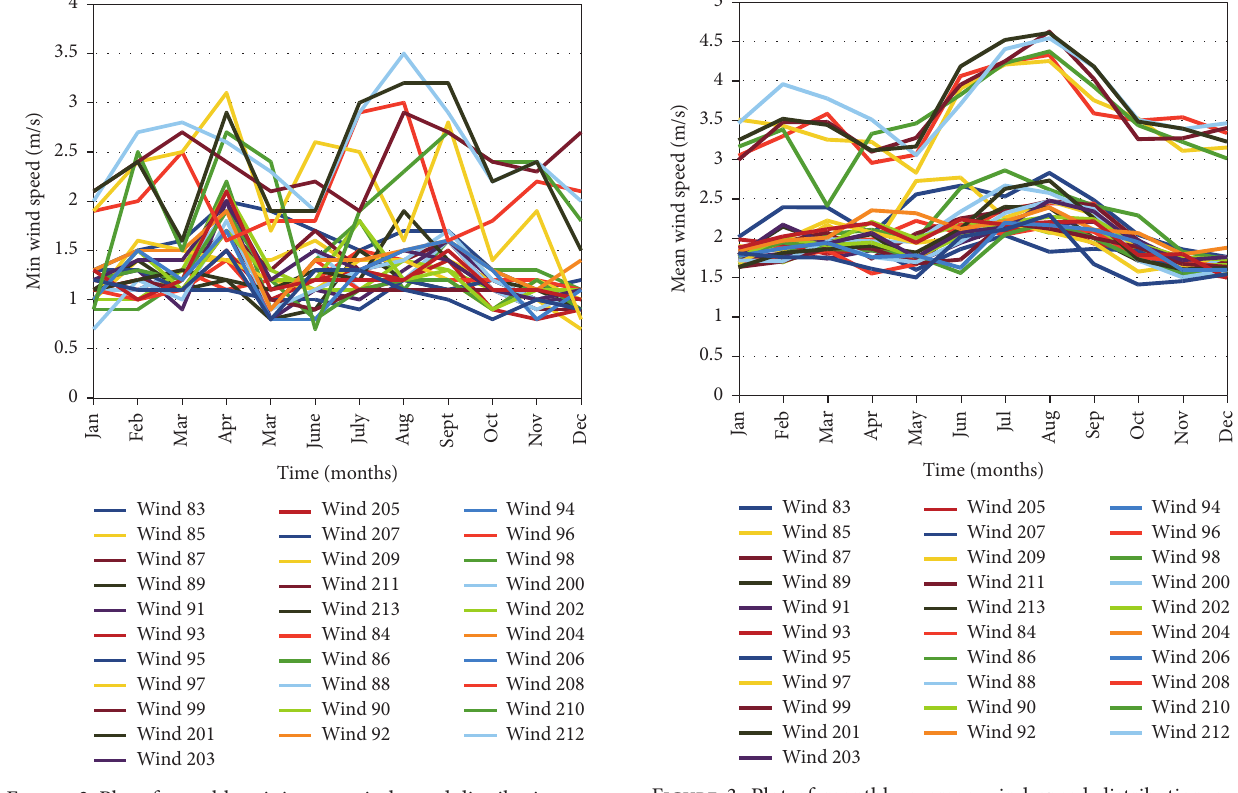
Figure 2: Plot of monthly minimums wind speed distribution over Debuncha for 31 years’ period.